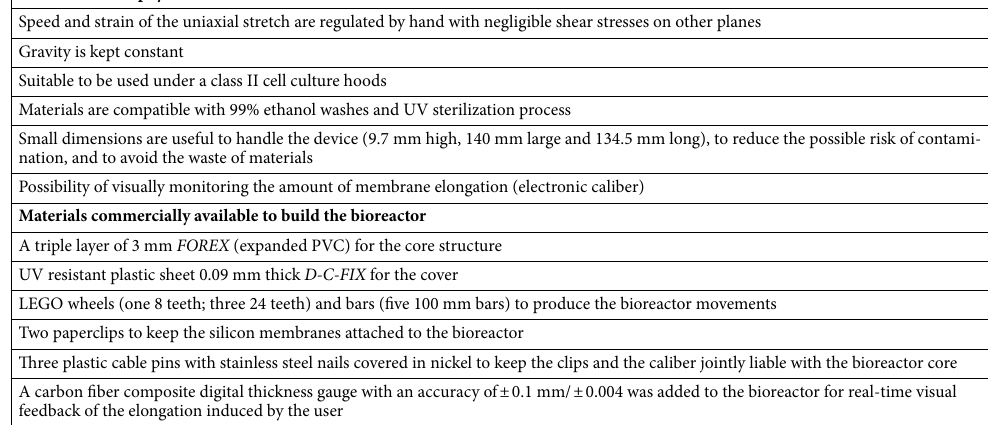
Table 1. Detailed features of the bioreactor used for mechanical